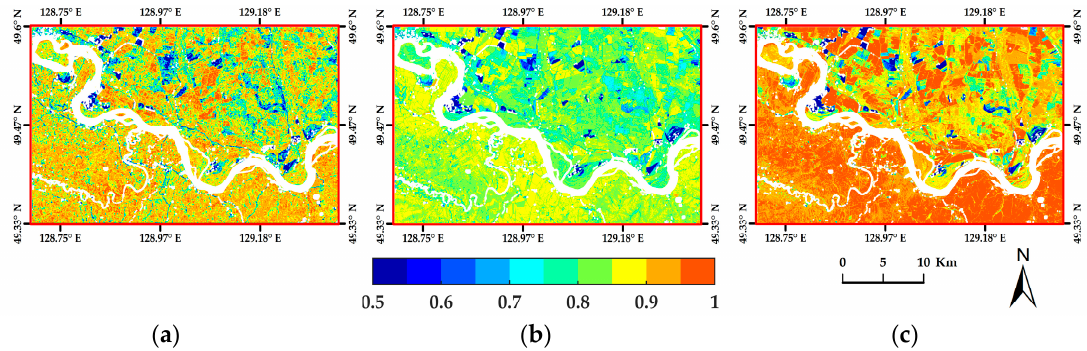
Figure 6. Comparisons between different NDVIs. ( a ) Atmospheric corrected NDVI by using NP algorithm and ( b ) AFVI and ( c ) ARVI. ( a ) NDVI NP: mean = 0.862, RMSE = 0.067; ( b ) AFVI: mean = 0.823, RMSE = 0.056; ( c ) ARVI: mean = 0.917, RMSE = 0.052.